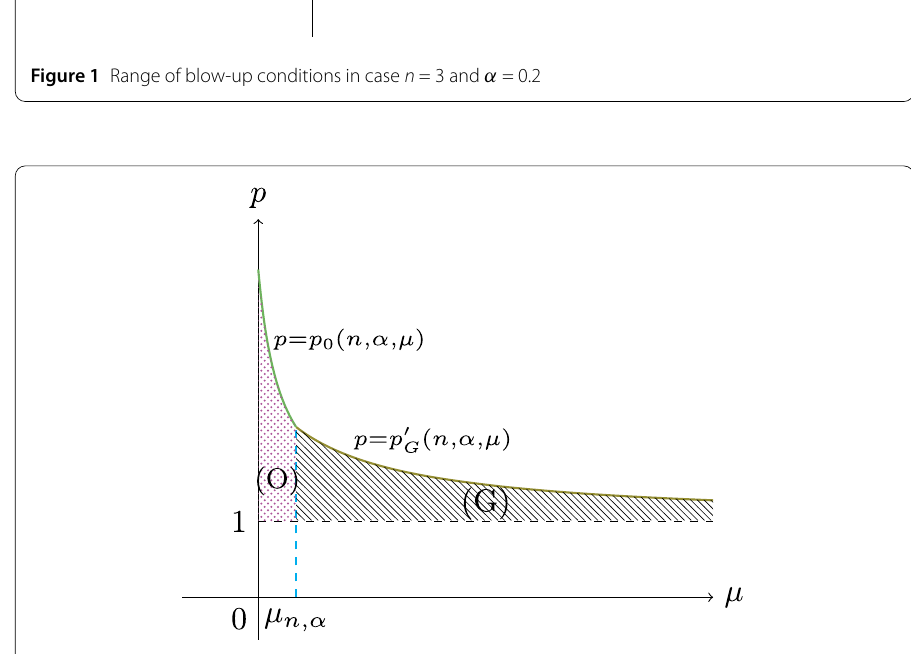
Figure 2 Range of blow-up conditions in case n = 3 and α =